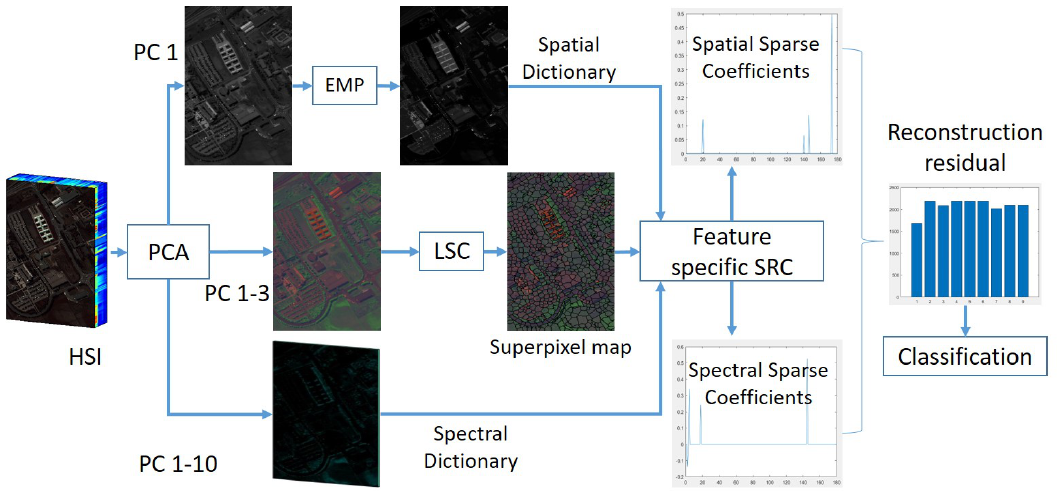
Figure 1. The flowchart of the proposed SPFS-SRC